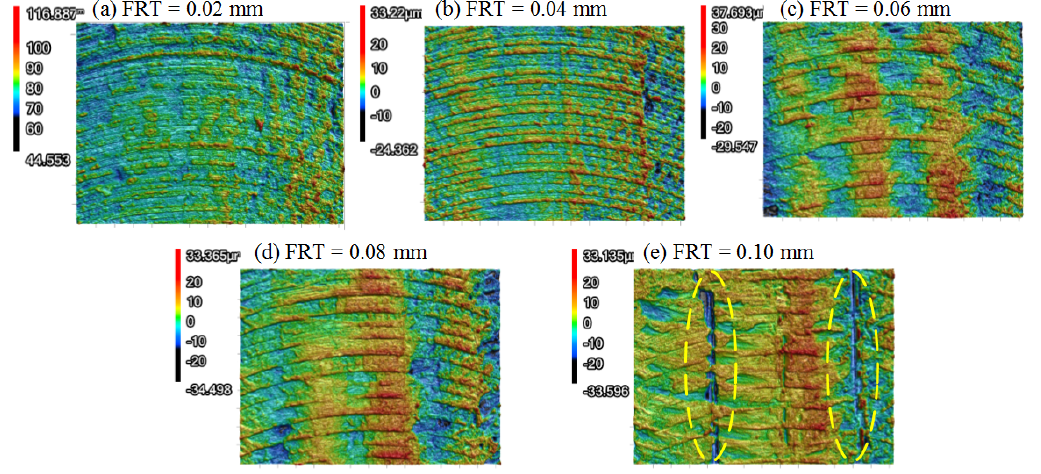
Figure 14. 3D morphologies comparison of PEEK samples under different FRTs (RA = 0 ◦ , LT = 0.1mm, SS = 3000r/min): ( a )